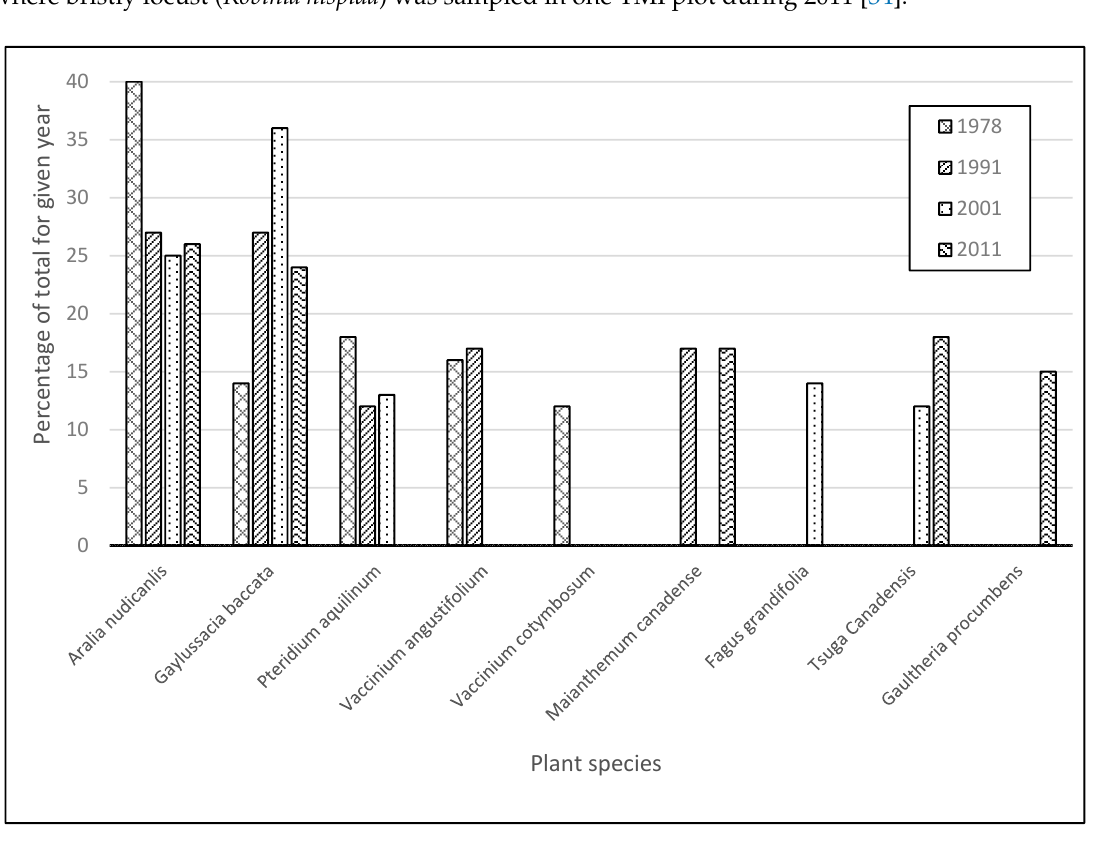
Figure 2. Understory dominant species by importance for all four sampling years. Values represented by percentages of the total importance value of all nine species for three islands.